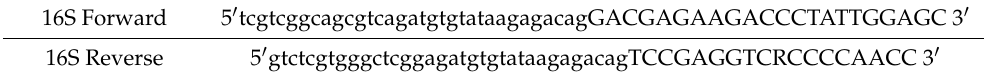
Table 2. The oligodeoxynucleotide sequences of the universal primers for 16S rRNA gene amplifica- tion designed by Tillmar et al., 2013 [17] (the letters in small case are Nextera adapter